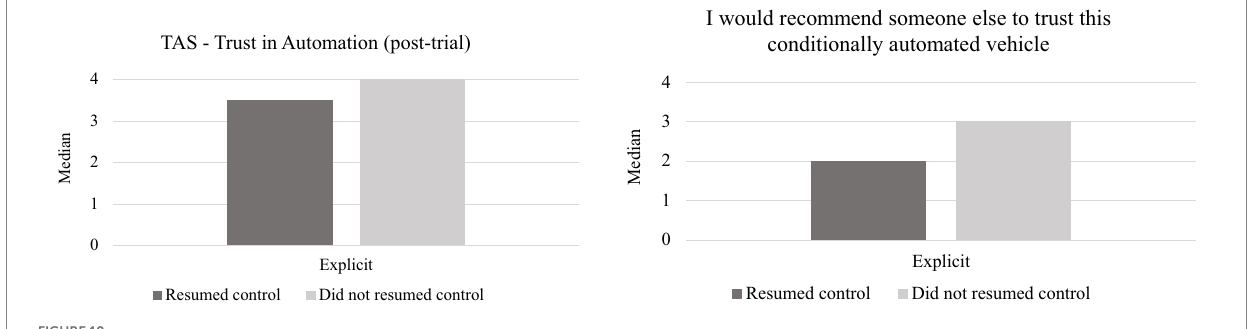
FIGURE 10 Median values for the trust in automation dimensions and bespoke items depending on whether participants resumed control after the explicit failure.